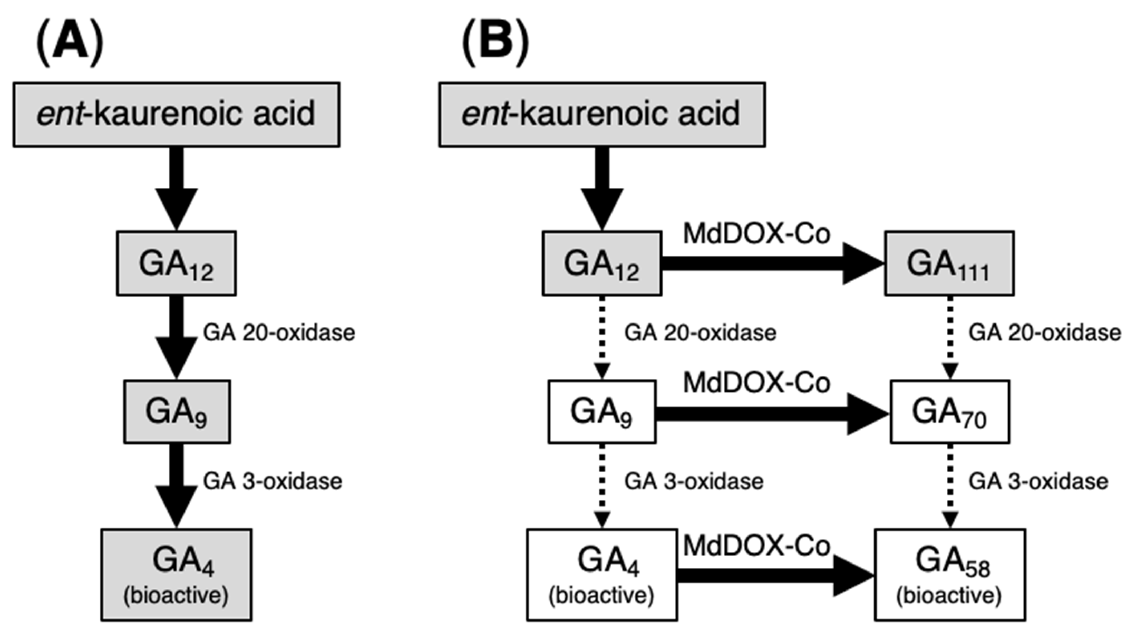
Figure 3. Effect of MdDOX-Co on the biosynthesis of bioactive gibberellin (GA). ( A ) Simplified GA 4 biosynthesis pathway in plants. ( B ) MdDOX-Co metabolizes GA 12 , GA 9 , and GA 4 to GA 111 , GA 70 , and GA 58 , respectively; conversion of GA 12 to GA 111 by MdDOX-Co prevents the biosynthesis of bioactive GAs. Reproduced with permission from Okada [9].